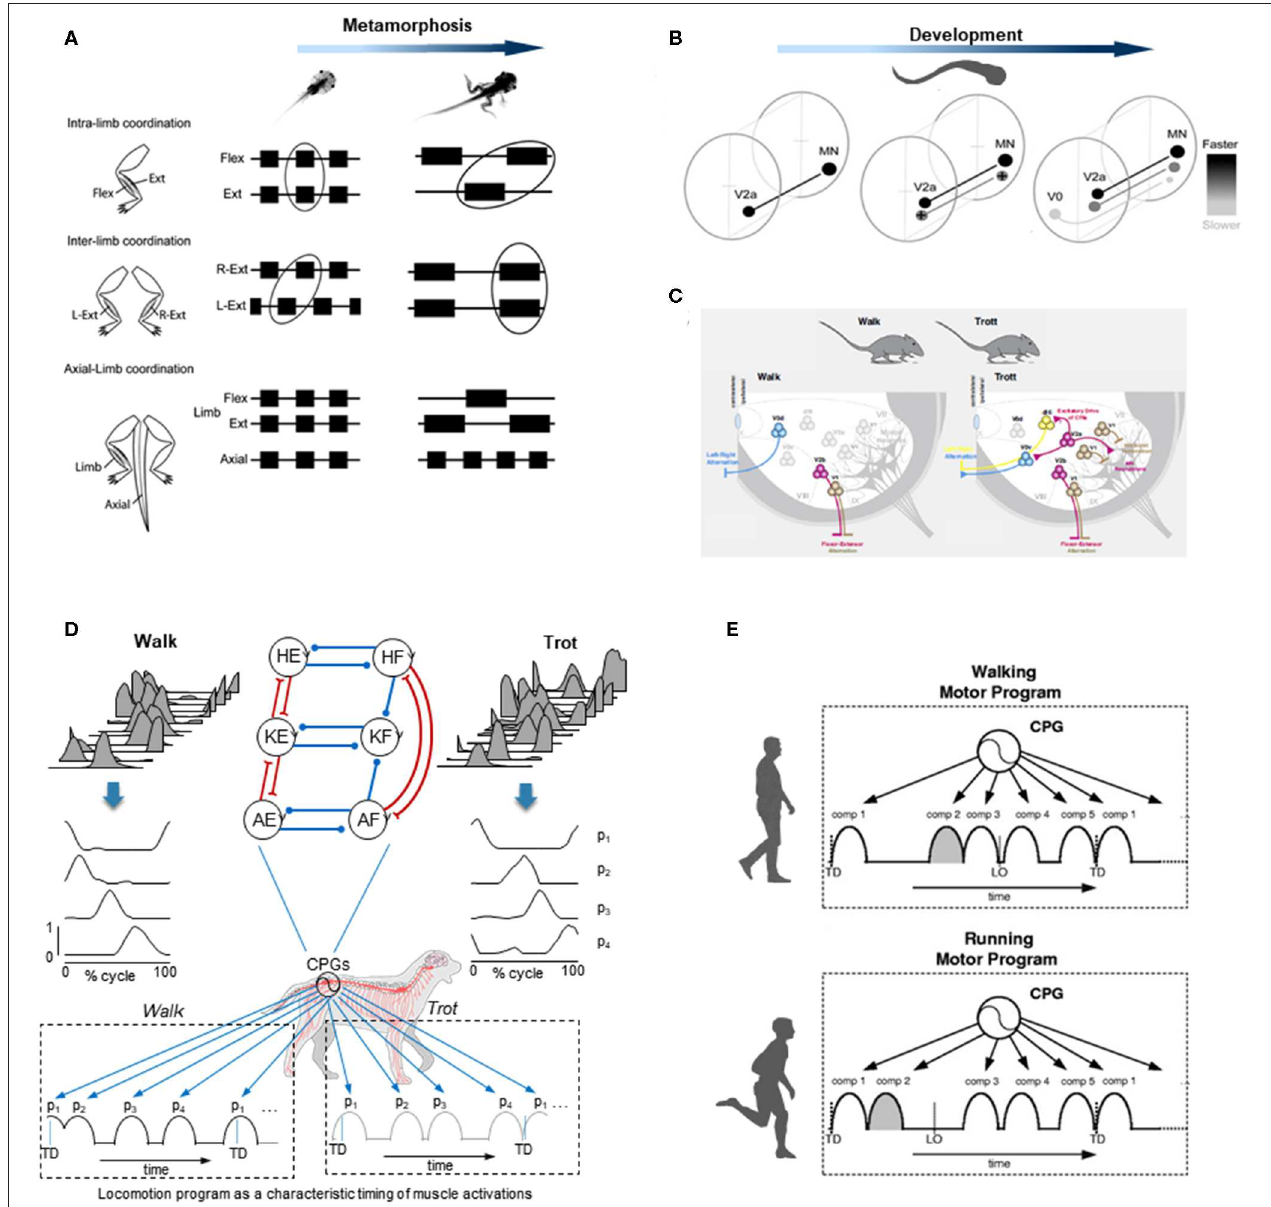
FIGURE 2 | Examples of gait-specific changes in spinal locomotor controllers. (A) changes in coordination between extensor, flexor, and axial muscle bursts during Xenopus metamorphosis (modified from Rauscent et al., 2006 with permission from Elsevier). (B) schematic summary of changes in the development and recruitment of spinal circuitry in larval Zebrafish: neurons responsible for progressively slower movements in larvae are added as zebrafish develop (modified from Fetcho and McLean, 2010 with permission). (C) distinct spinal interneurons circuits drive different gaits in mice (modified from Deska-Gauthier and Zhang, 2019 with permission from Elsevier). (D) locomotion program as a characteristic timing of muscle activations during walk ( left ) and trot ( right ) in dogs. From top to bottom: averaged hindlimb EMG data, basic activation patterns (p1-p4) obtained by decomposing muscle activity and a schematic sequence of activation patterns for each gait (modified from Catavitello et al., 2015). Schematic representation of the unit burst generator CPG model is also plotted on the top (circles are interneurons controlling hip (H), knee (K), and ankle (A) extensors (E) and flexors (F), excitatory and inhibitory connections are represented by lines ending with forks or circles, respectively) (redrawn from Grillner and El Manira, 2020). (E) locomotion motor program as a sequence of activation pulses for walking and running in humans (modified from Cappellini et al., 2006).